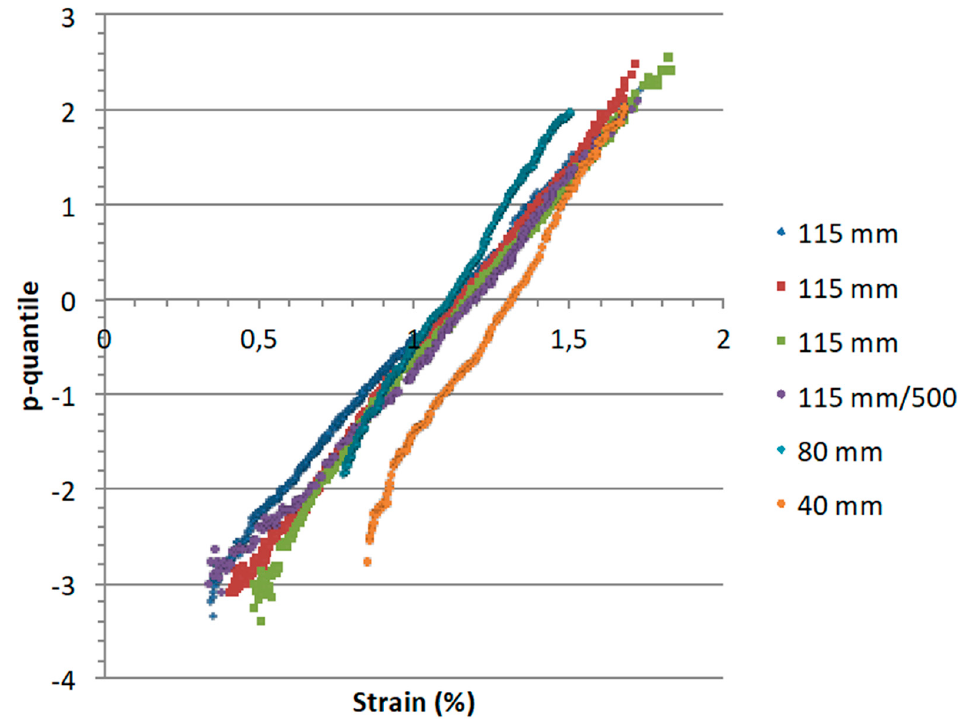
Figure 4. P-quantile z p ( ε p ) plots for various gauge lengths; 115 mm/500 refers to a tow with 500 filaments. Table 2. Values of mean ( µ ) and standard deviation ( s ) derived from the slope (1/ s ) and the intercept ( µ / s ) of the z p ( ε p ) plots. R 2 (z p ) is the coefficient of determination that measures the global fit of Equation (6). Values of Weibull modulus ( m ) and scale factor ( ε l ) derived from mean ( µ ) and standard deviation ( s ). R 2 (Pn-PW) is the coefficient of correlation that measures the global fit of normal and Weibull distribution